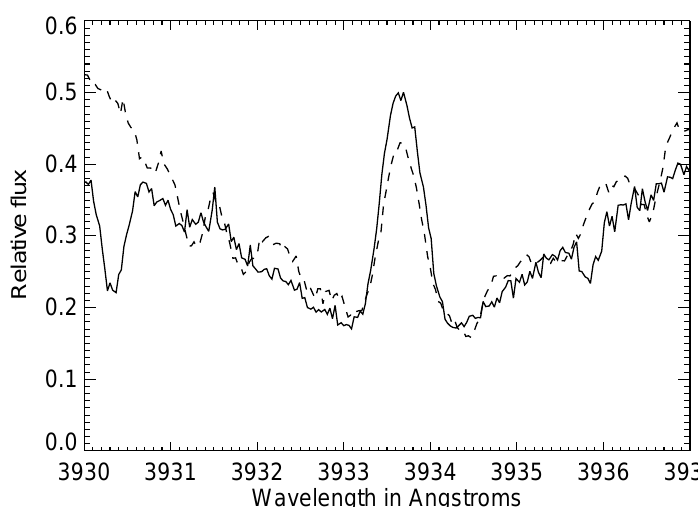
Fig. 1. The emission in the Ca II K line (solid line). The overplotted dashed line is the central part of the Ca II H line shifted by 34.81 ˚A. Observed on 2010 December 13, the NARVAL